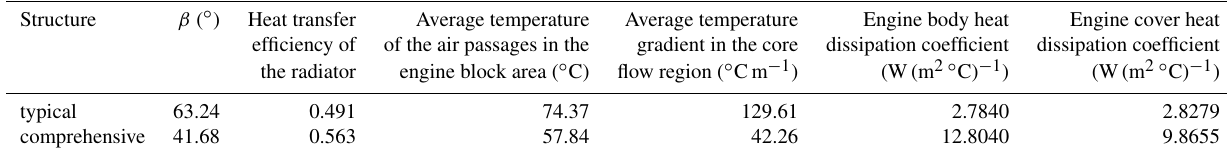
Figure 17. Infrared imaging temperature field map of high-temperature components in typical and comprehensive structure from the + Y direction under the 2000rmin − 1 steady-state condition. Table 2. Comparison of enhanced heat transfer parameters in the radiator assembly area and engine block